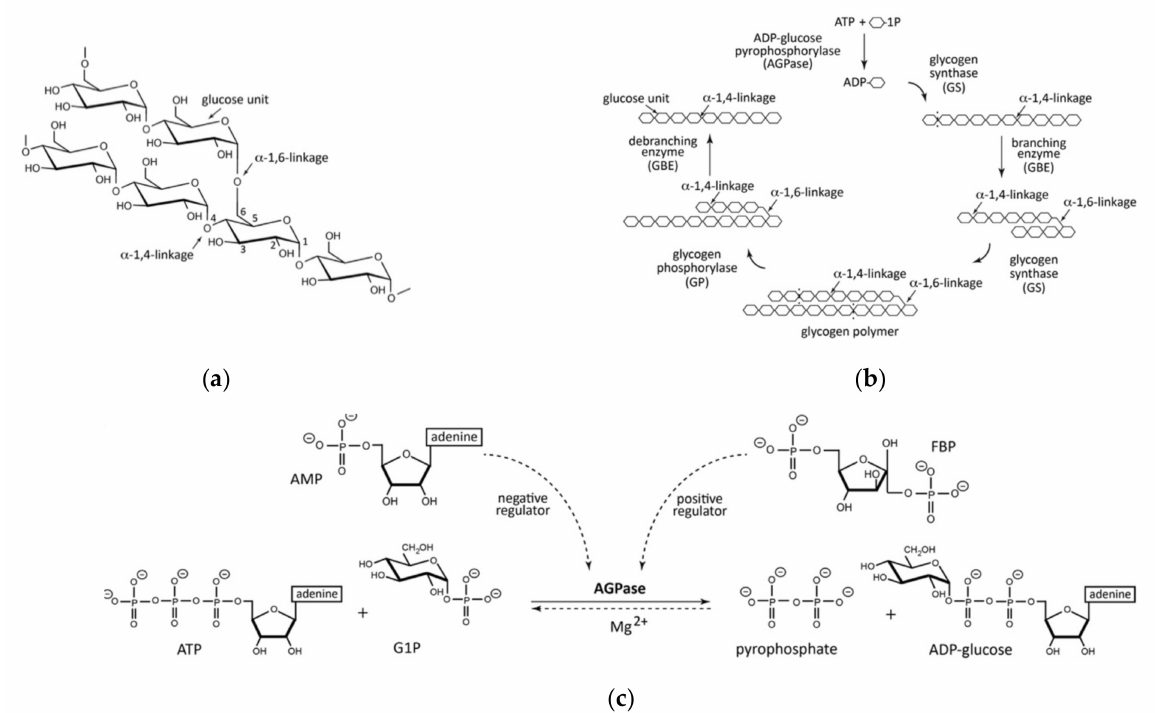
Figure 2. ( a ) The structure of glycogen, ( b ) biosynthetic pathway, and ( c ) regulatory pathway for glycogen accumulation in bacterial systems. Used with permission from Cifuente et al. [68]. © 2021 The Author(s). Published by Elsevier